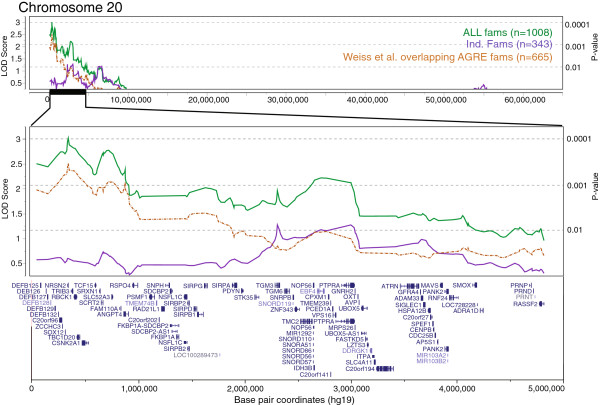
Independent replication of genome-wide significant linkage at 20p13. Genome-wide significant linkage signal at 20p13 from the combined sample (ALL fams; green, solid line), Autism Genetics Resource Exchange families (AGRE fams) analyzed by Weiss et al.[33] (orange, dashed line), and all AGRE families not previously analyzed by Weiss et al. [33] (Ind. Fams; purple, solid line). Top: linkage across the full chromosome 20; middle: linkage across a 2-logarithm of odds (LOD) interval from the peak LOD; bottom: RefSeq gene alignment in the 2-LOD interval. Dashed lines mark LOD thresholds corresponding to linkage P-values of 0.01, 0.001, and 0.0001 [35].